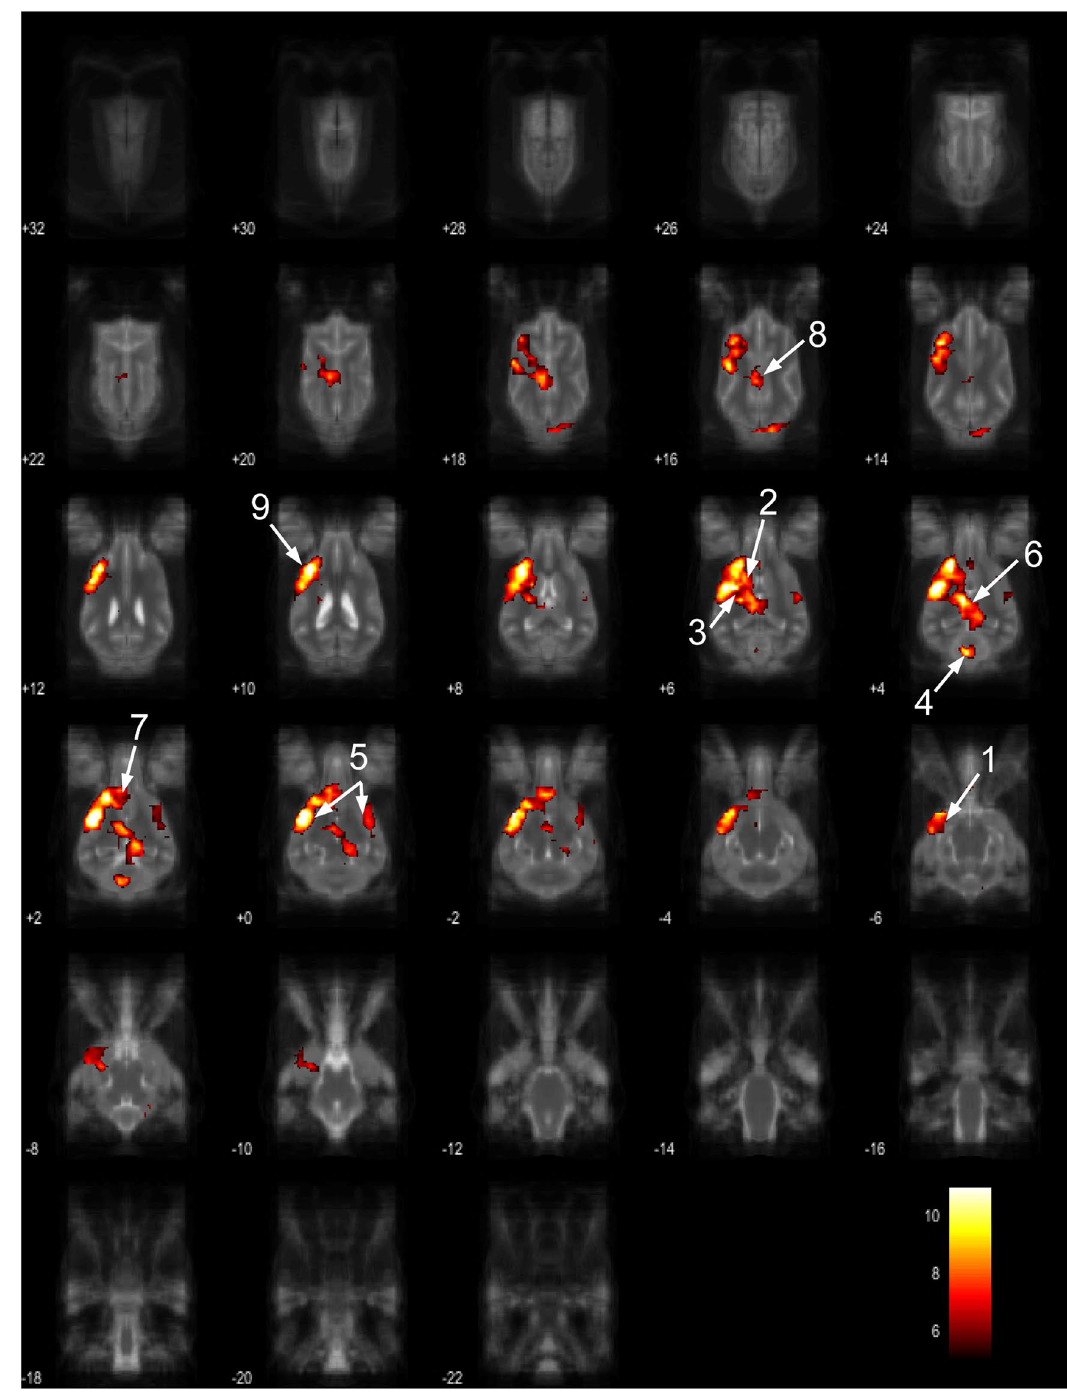
Figure 7. Resting-state network component D from the 15 component gICA. We report the results with a voxel-wise FDR corrected p < 0.001 and cluster treshold of FDR corrected p < 0.005. gICA components are presented as thresholded T-maps, corrected for multiple comparisons, overlaid on the Nitzsche atlas 15 . 1.left amygdala, 2. left caudate nucleus, 3. striatum, 4. cerebellum, 5. bilateral insular cortex, 6. thalamus, 7. medial prefrontal cortex, 8. mid-cingulate gyrus, 9. left rostral composit